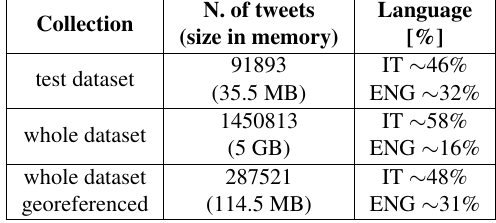
Table 1. Collected data